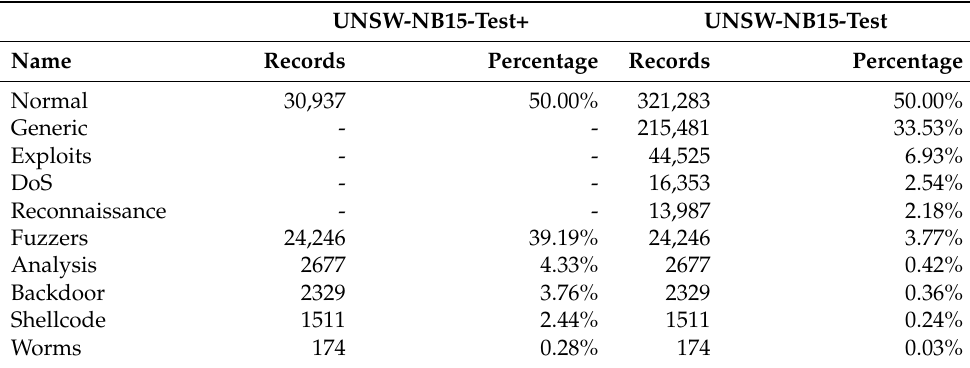
Table 5. UNSW-NB15-Test+ and UNSW-NB15-Test datasets.